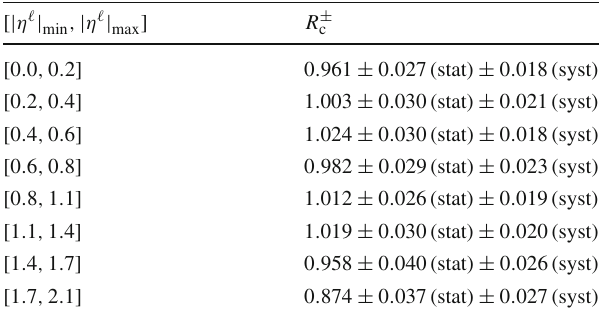
Table 9 Measured cross section ratio R ± c as a function of | η (cid:3) | , from the combination of all four channels